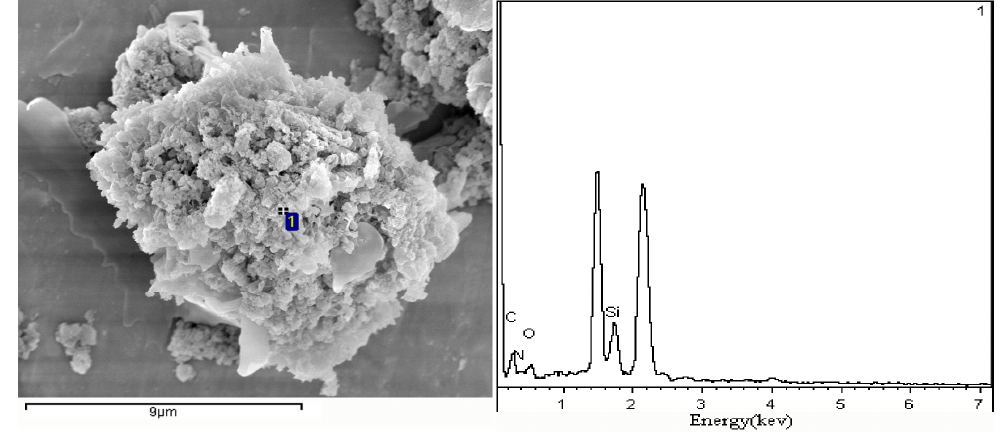
Figure 4. The EDS analysis of CS015-300.